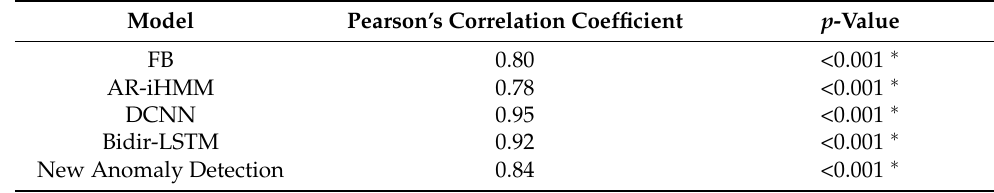
Table 3. Correlation between the gold standard and the gait detection models in the OAs